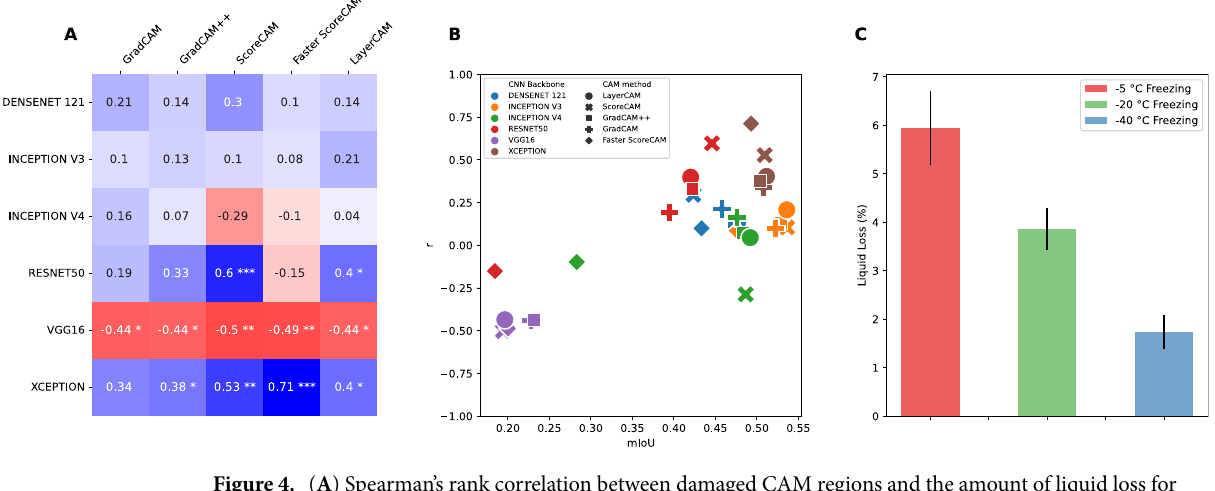
Figure 4. ( A ) Spearman’s rank correlation between damaged CAM regions and the amount of liquid loss for reach CNN model and CAM method combination. ( B ) Overview of the relationship between mIoU scores (x-axis) and the correlation with liquid loss (y-axis) for each CNN model and CAM method combination. ( C ) Liquid loss as a percentage of the weight of the sample for each of the three freezing protocols. Error bars represent the 95% confidence interval. *p < 0.05, **p < 0.01, ***p <